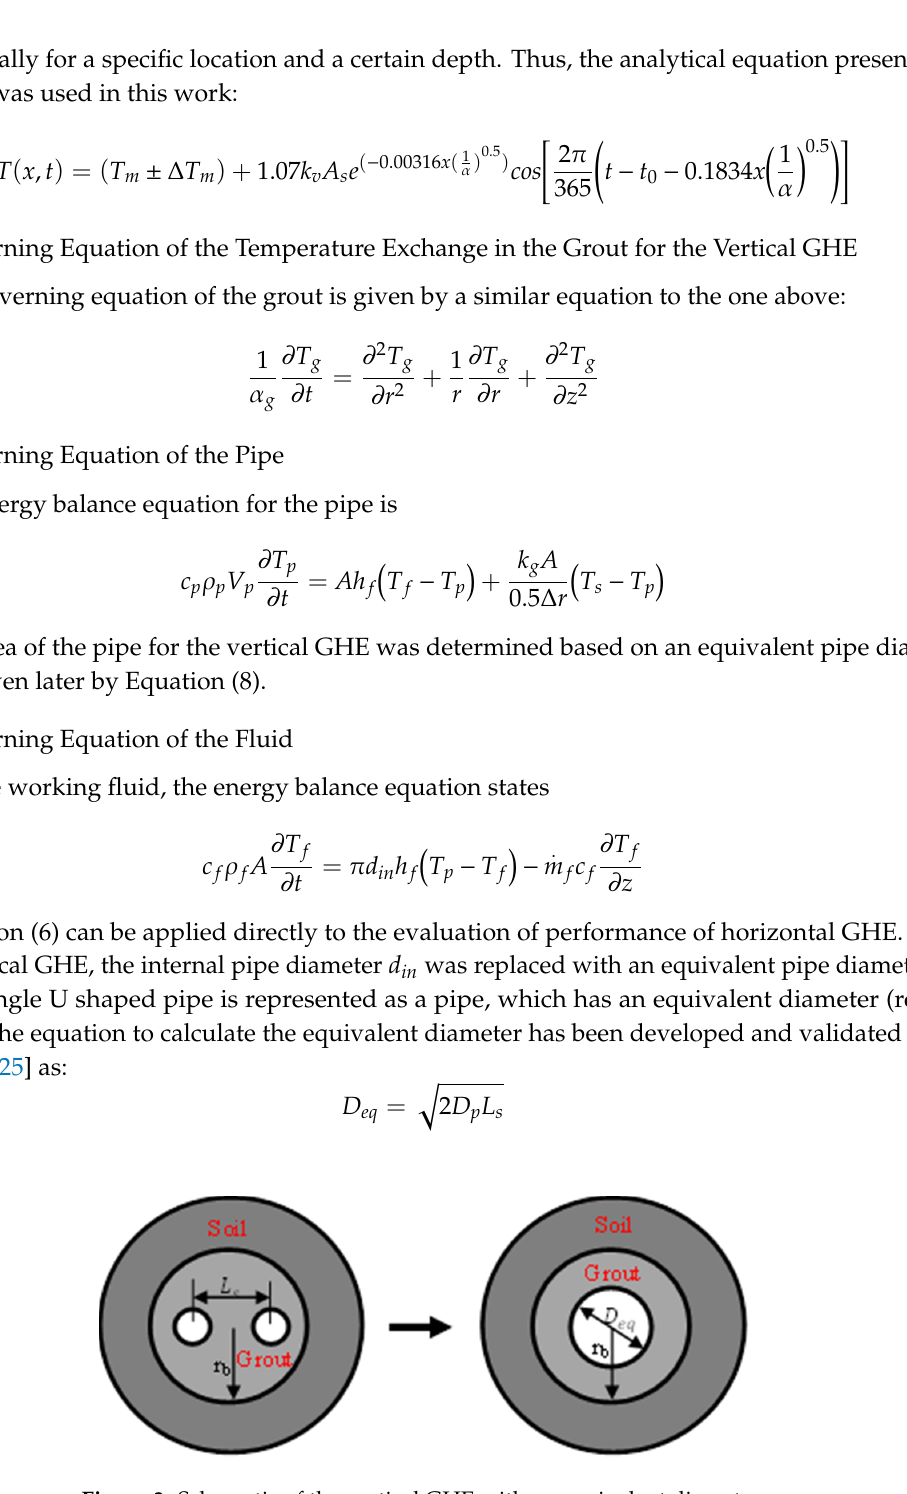
Figure 3. Schematic of the vertical GHE with an equivalent diameter.